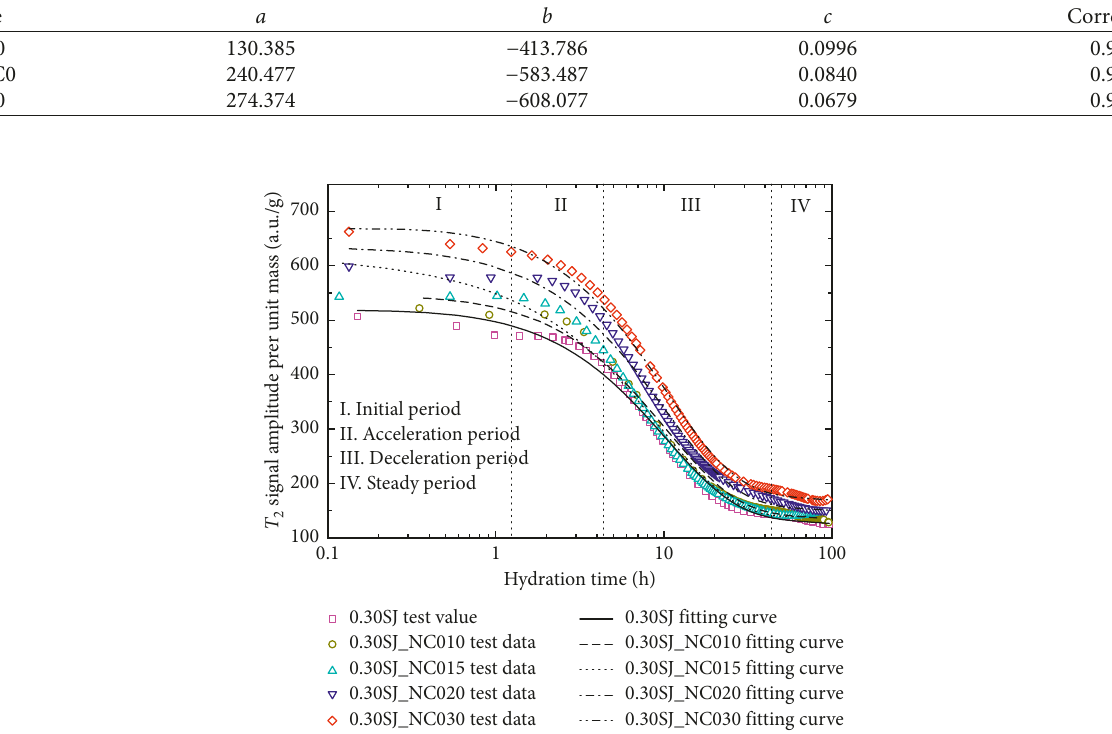
Figure 8: Experiment data and fitting curves of cement pastes with different NC